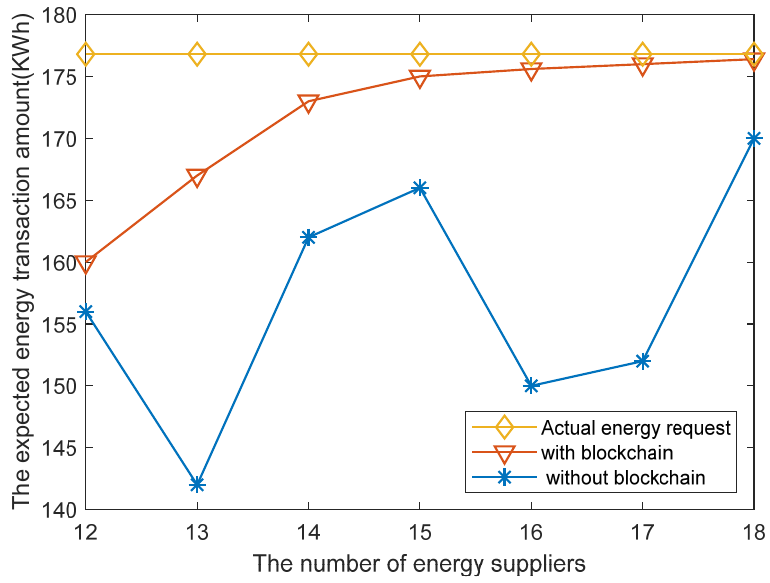
Figure 7. The performance with/without blockchain when the number of energy suppliers varies.